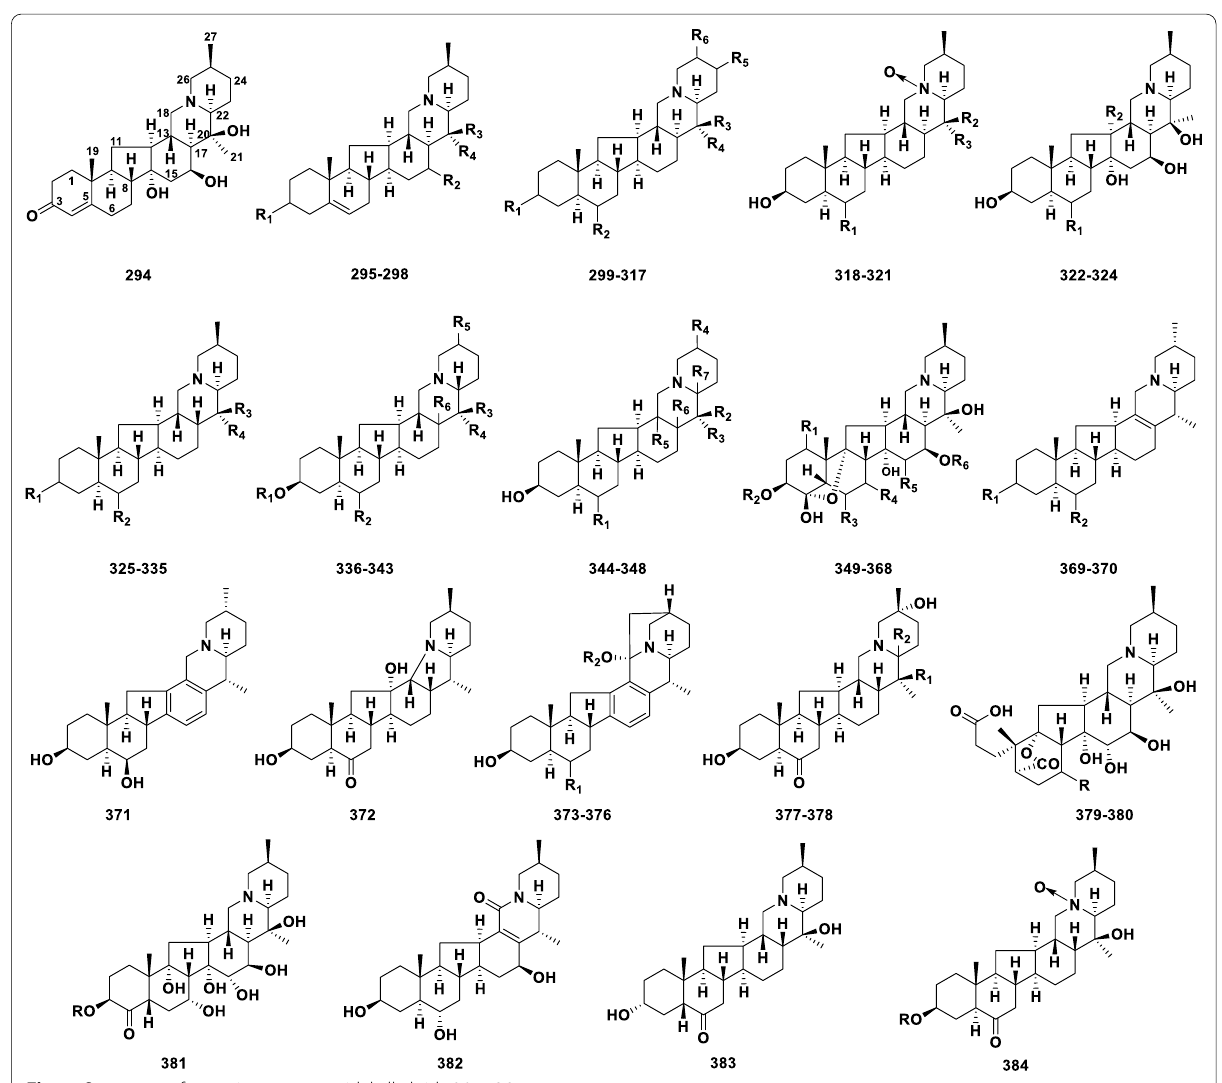
Fig. 7 Structures of cevanine type steroidal alkaloids